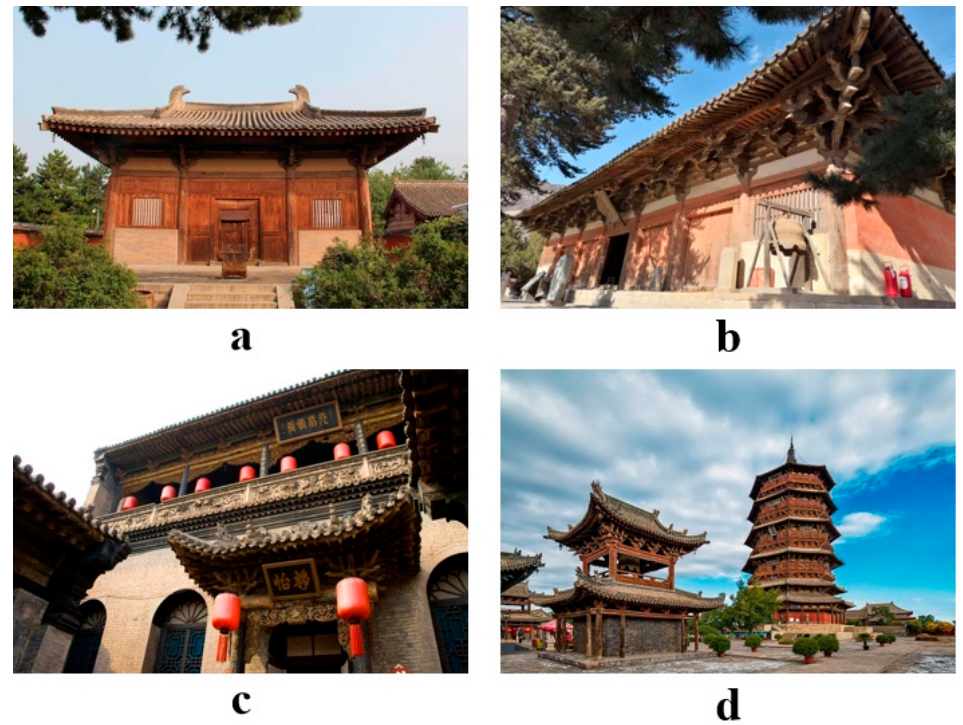
Figure 1. Famous ancient wooden buildings in Shanxi Province.